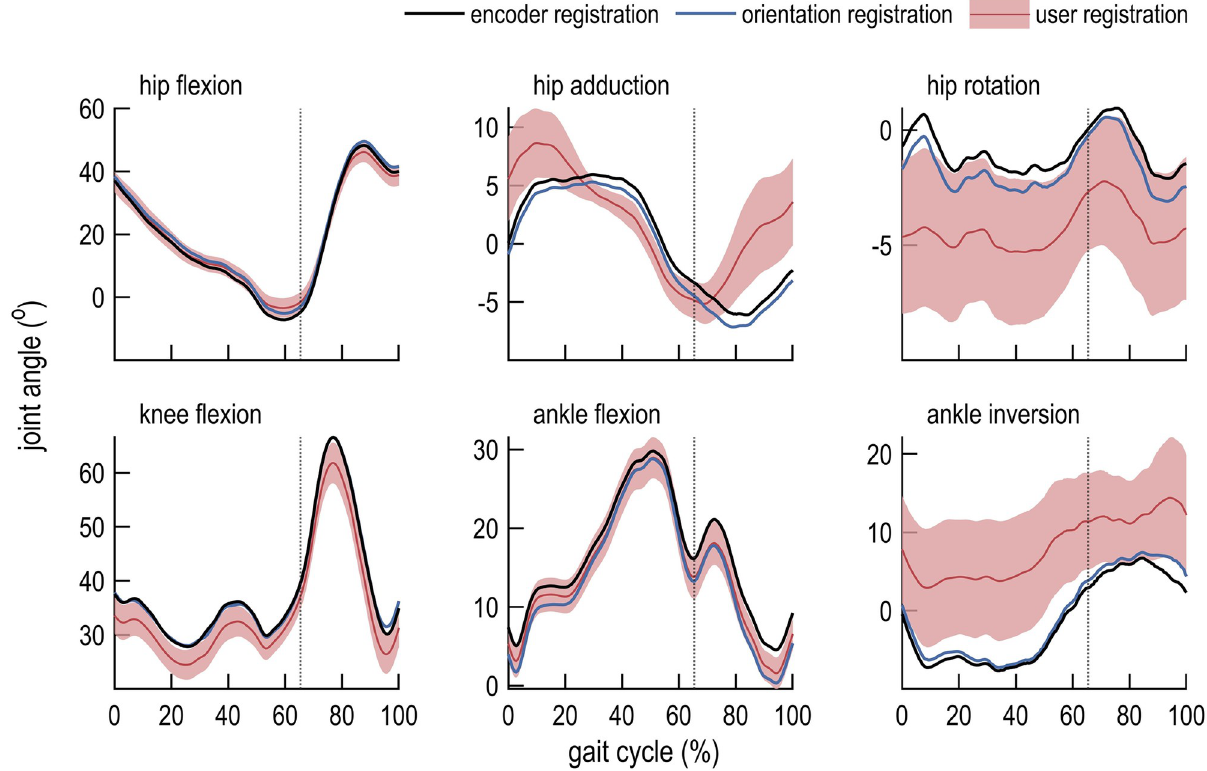
Fig 3. Inverse kinematics computed using three registration methods. Joint angles were computed over one gait cycle using encoder registration (black line), orientation registration (blue line), and user registration (mean, red line; standard deviation, shaded). Toe-off is indicated by a dotted vertical